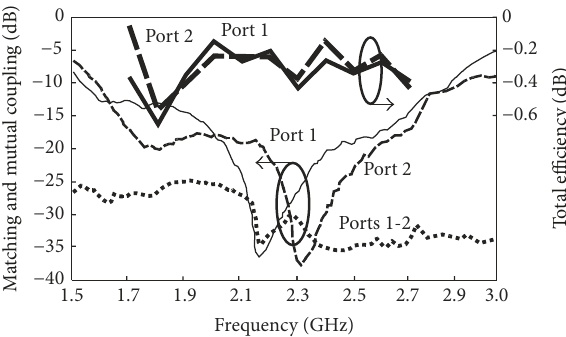
Figure 3: Measured impedance matching, mutual coupling between antenna feed ports, and total efficiency as a function of frequency.